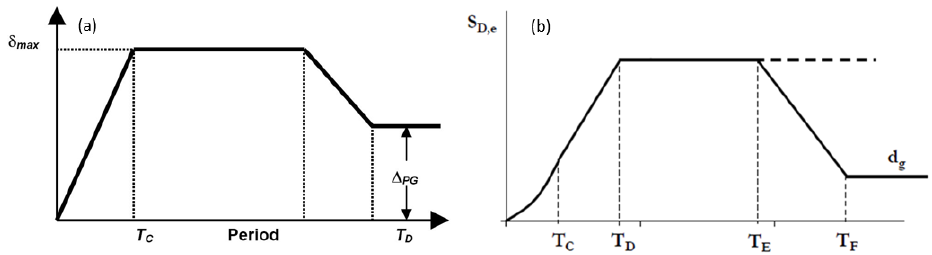
Figure 22. ( a ) IBC displacement spectrum [35] ( b ) Eurocode-8 displacement spectrum [66] .